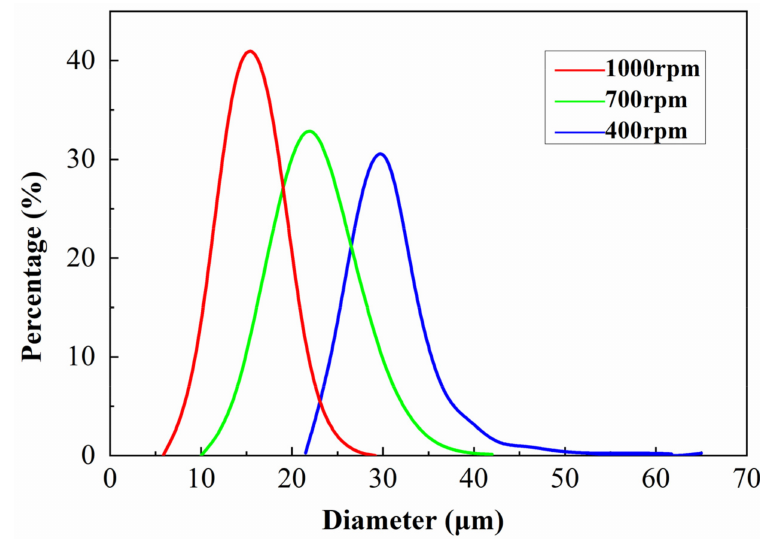
Figure 3. Particle size distribution of TSF microcapsules under different stirring